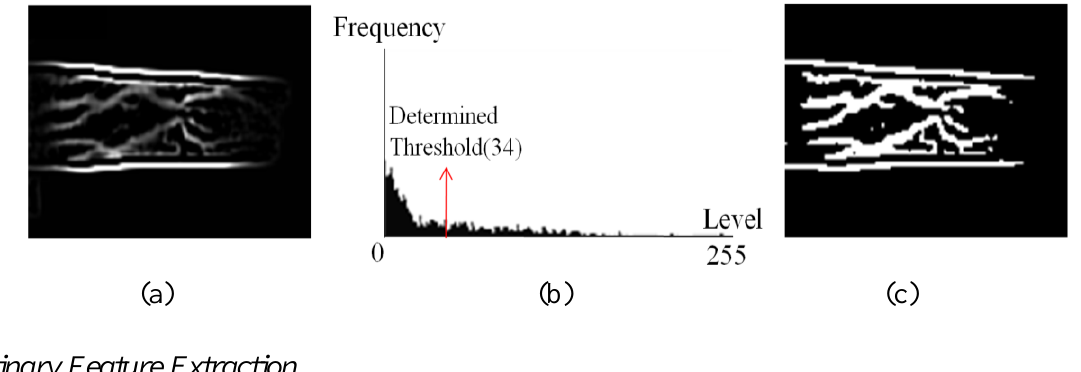
Figure 6. Example of simple binarization method. (a) Filtered finger image, (b) histogram of image in (a) and an automatically determined threshold, and (c) a resulting image after binarization using the